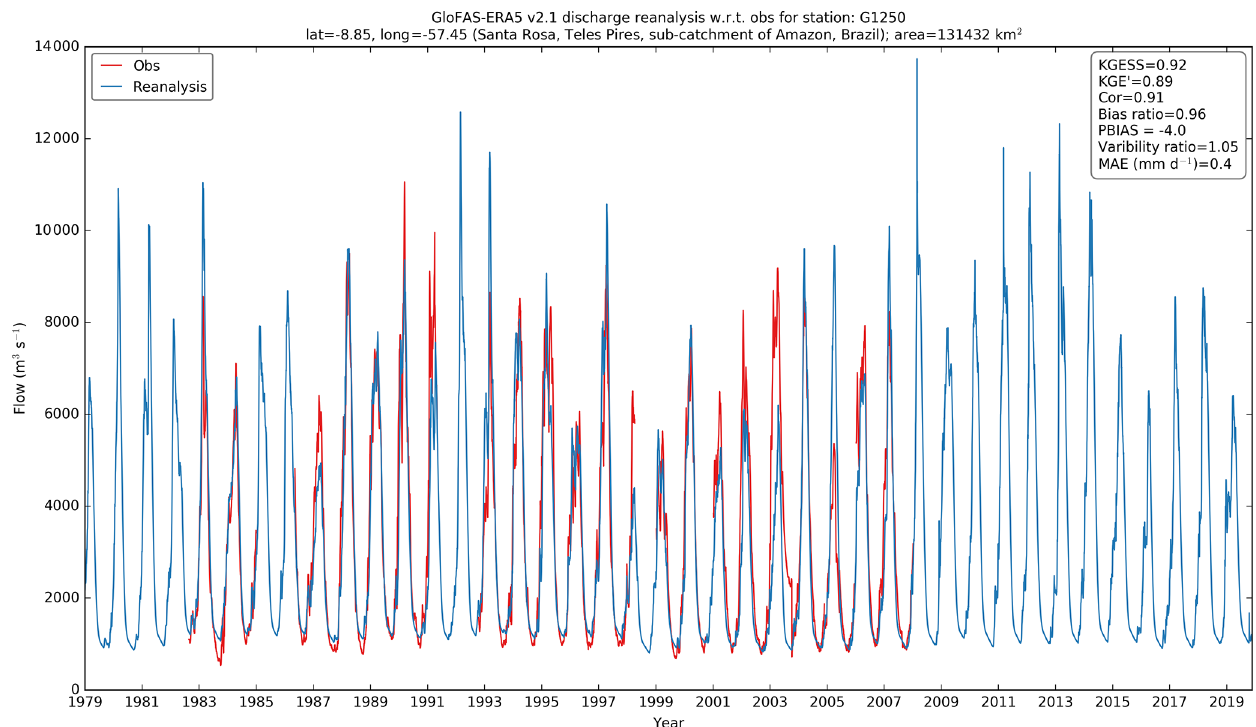
Figure 3. Hydrograph for GloFAS-ERA5 river discharge reanalysis (blue line) from 1 January 1979 to 12 November 2019 and observations (red line), when available, for the Santa Rosa gauging station on the Teles Pires River, a sub-catchment of the Amazon, Brazil (GloFAS ID = 1250; GRDC ID = 3629770). Summary statistics from the evaluation of the reanalysis against observations in top right box as used in Sect.